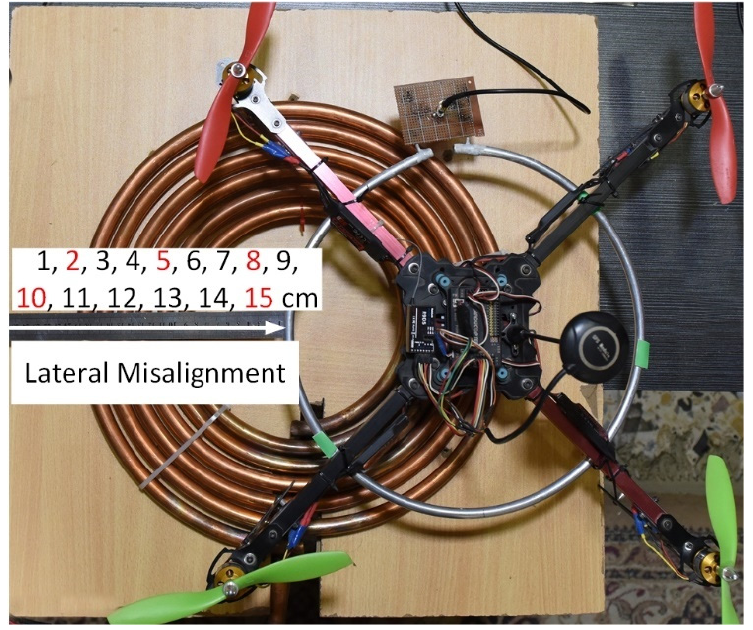
Figure 7. Lateral misalignment distance tests of 2 cm, 5 cm, 8 cm, 10 cm, and 15 cm with the base station pad.